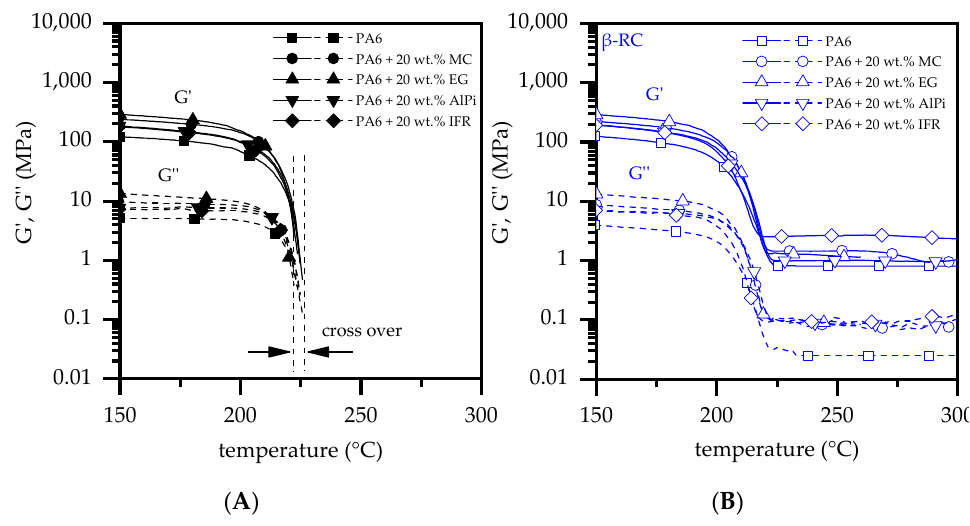
Figure 8. Torsion DMA results representing storage (G ′ ) and loss (G ″ ) moduli for ( A ) non ‐β‐ RC samples and ( B ) β‐ RC samples; 1 Hz; 0.05% strain.